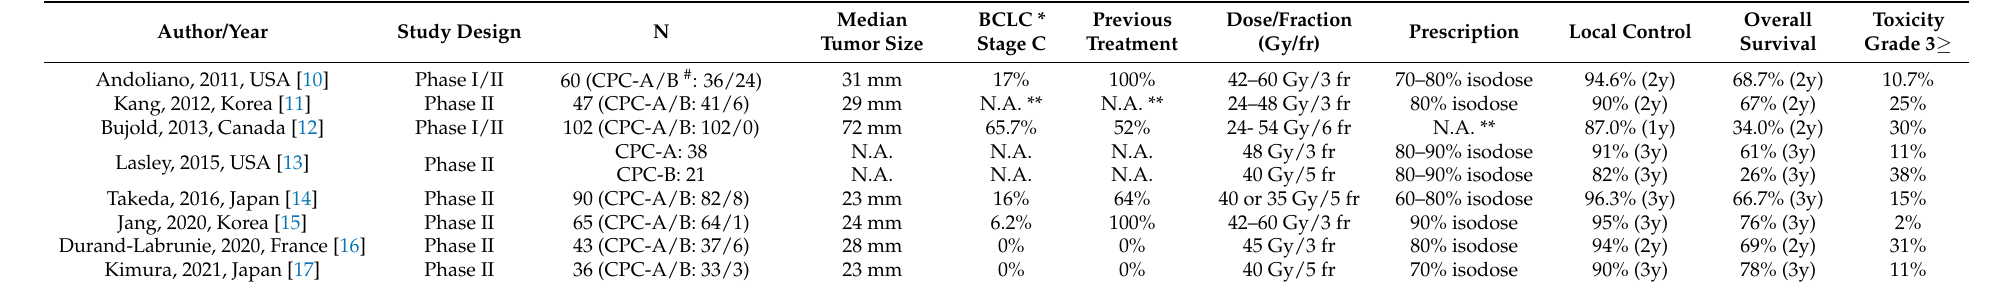
Table 1. Prospective studies of SBRT in early-stage